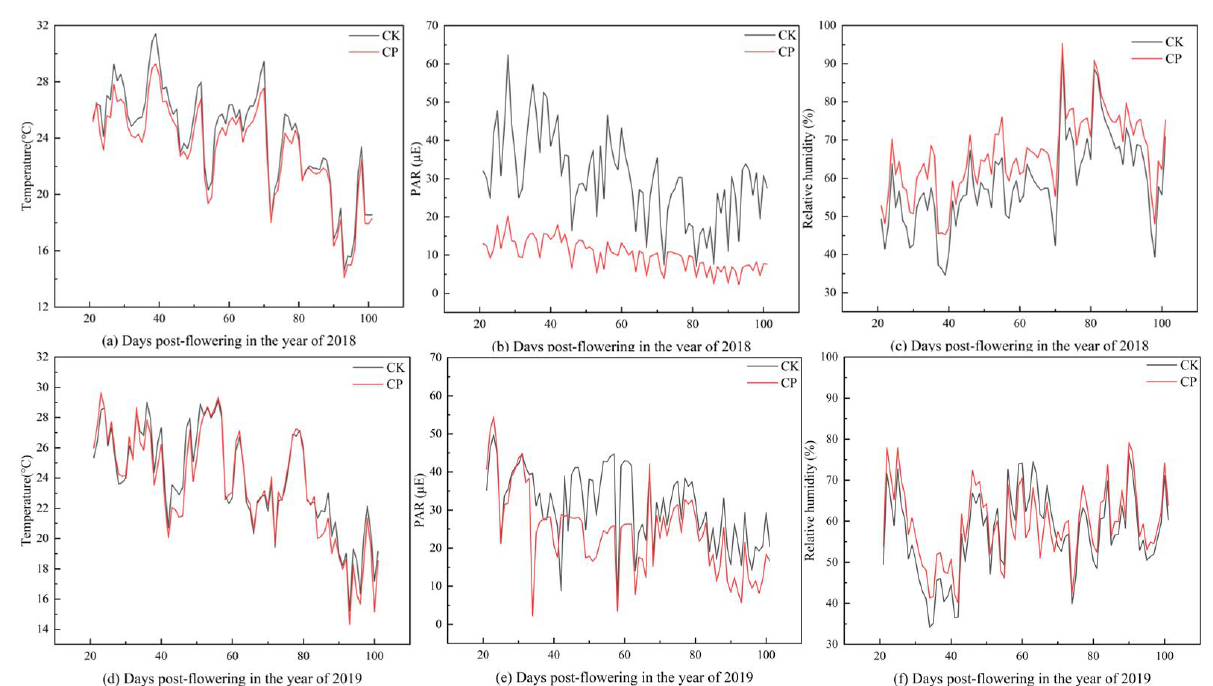
Apr to Oct in the experimental vineyards compared to the vintages from 2009-2019.